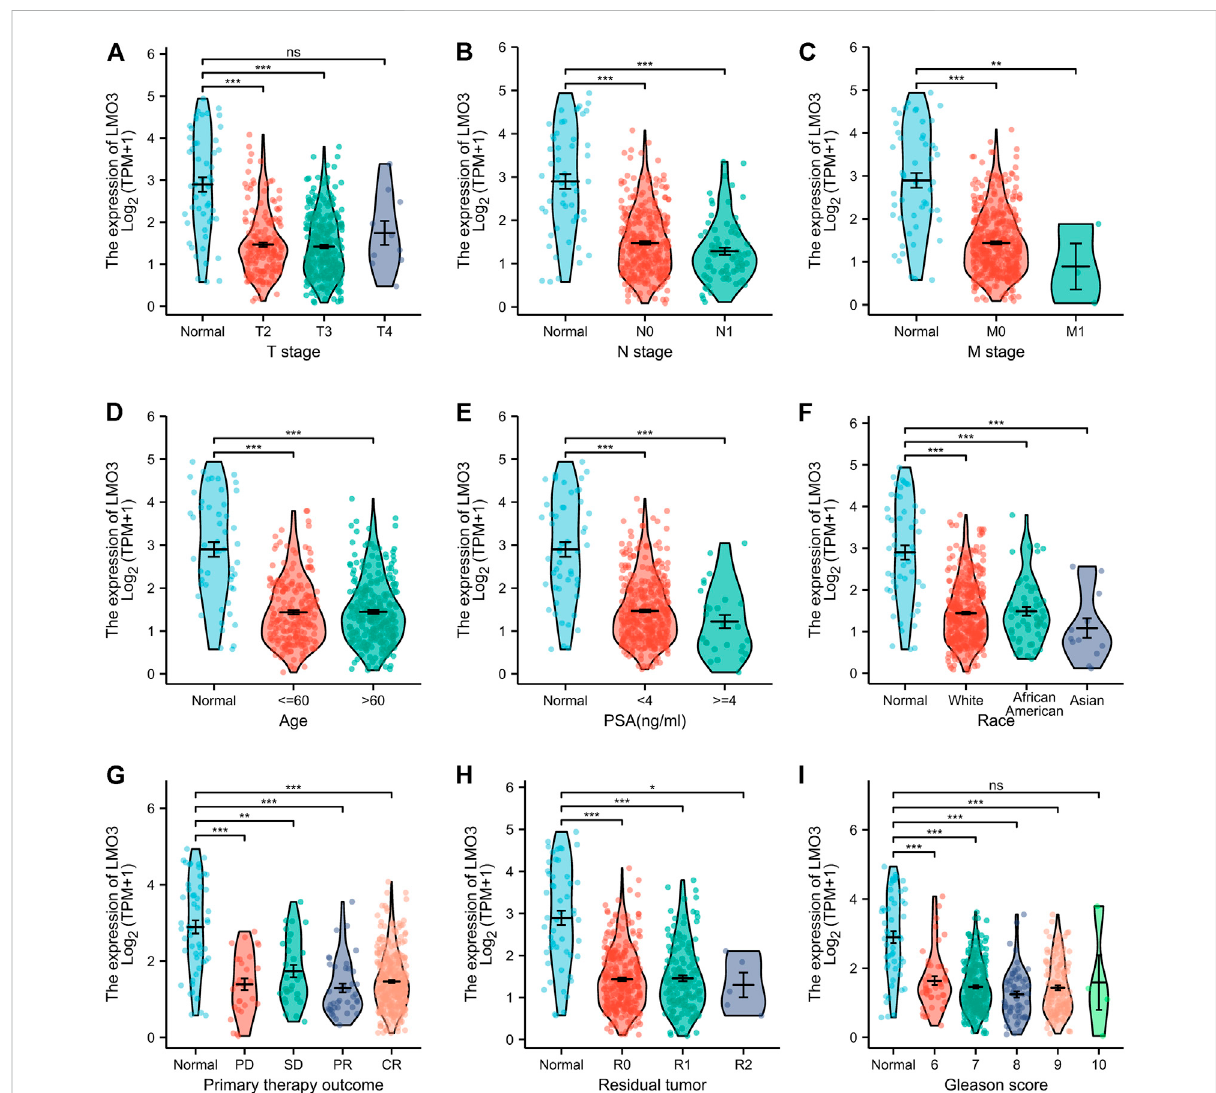
FIGURE 2 Box plots evaluating LMO3 expression among different groups of patients based on clinical parameters. Analysis is shown for tumor stage (A) , cancerstage (B) ,metastasis (C) ,age (D) ,PSA (E) ,Race (F) ,primarytherapyoutcomes (G) ,residualtumor (H) Representatveimmunoblotand (I)